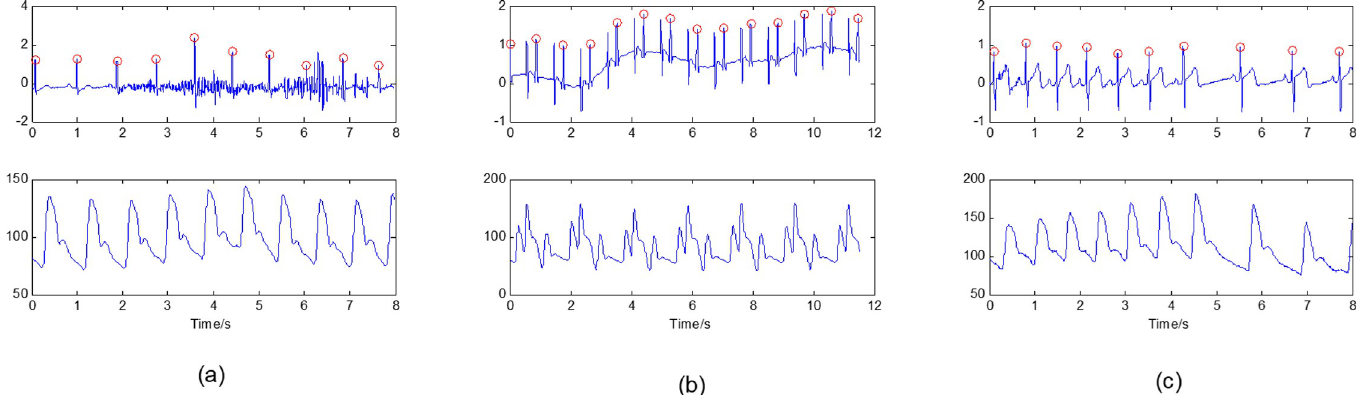
Fig 12. Successfully detecting the R-wave peaks in different patterns using our proposed algorithm. (a) A record with noisy ECG signal; (b) A record with pacemaker; (c) A record with a sudden change of RR-intervals.